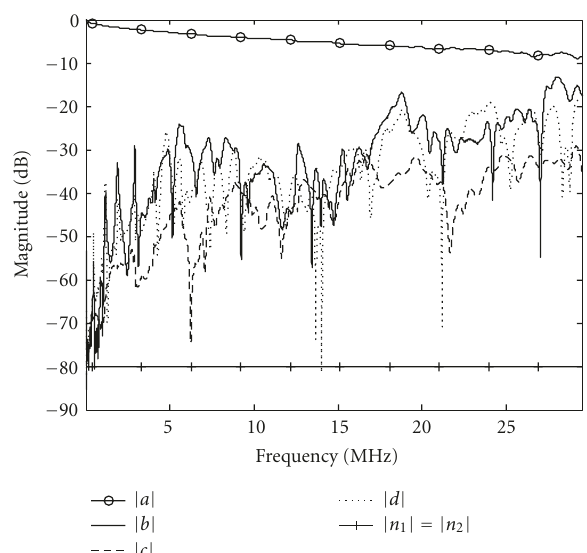
Figure 2: Channel properties a , b , c , d obtained from measure- ments. The y -axis denotes relative magnitude in dB (the raw re- sults are normalised by the magnitude of the largest a -value). As- suming a VDSL transmit PSD of − 60 dBm/Hz results in a level of n − 80 dB for n 1 and 2 in order to obtain a background-noise PSD of − 140 dBm/Hz, which is the level suggested in standardisation doc- uments [8,